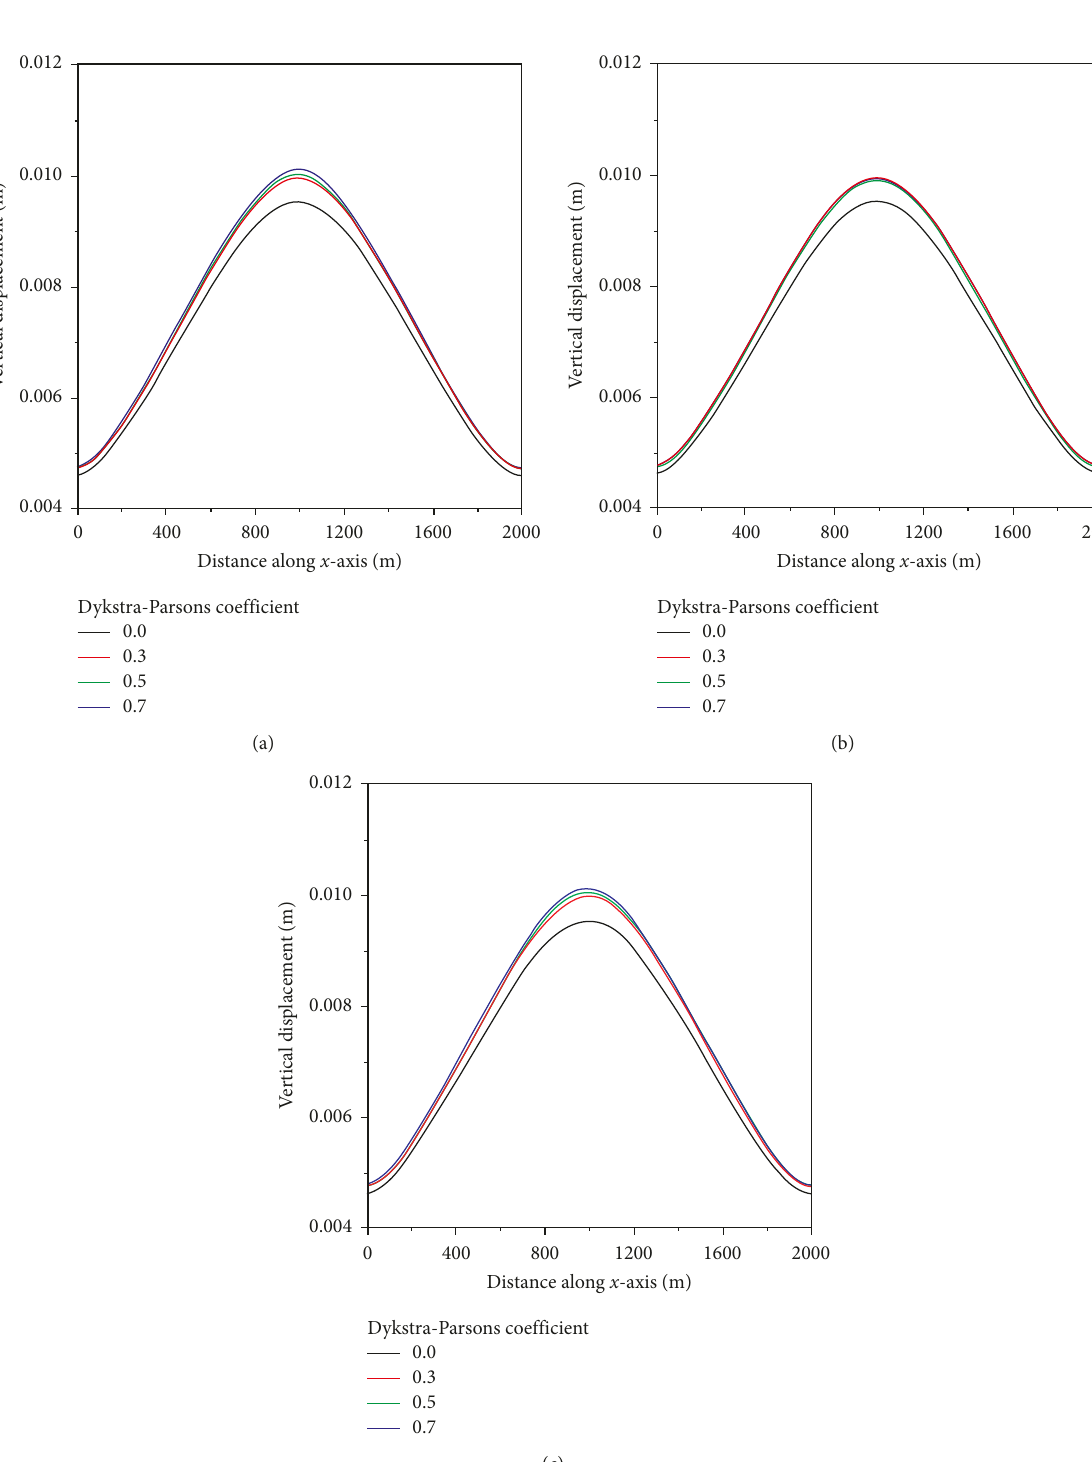
Figure 9: Vertical displacement of top of caprock: Cases A, B, and